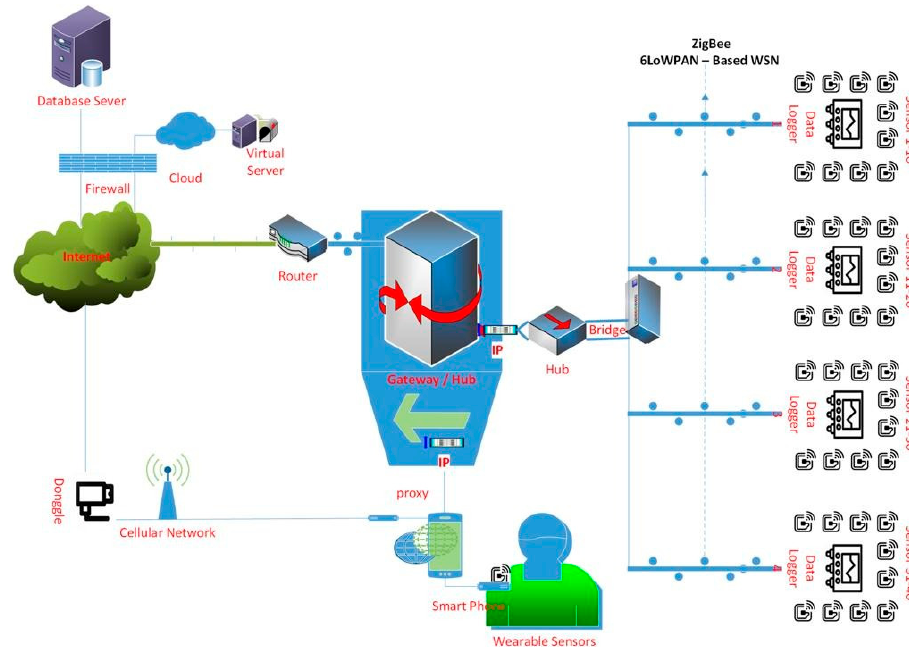
Figure 12. A suggested network of ZigBee application for validation by applying in different buildings as future investigation.